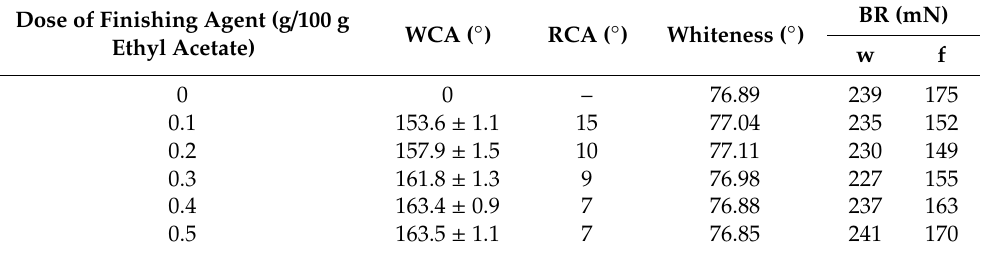
Table 3. Performance properties of the cotton fabrics treated with PFAS-SiO 2 -3.